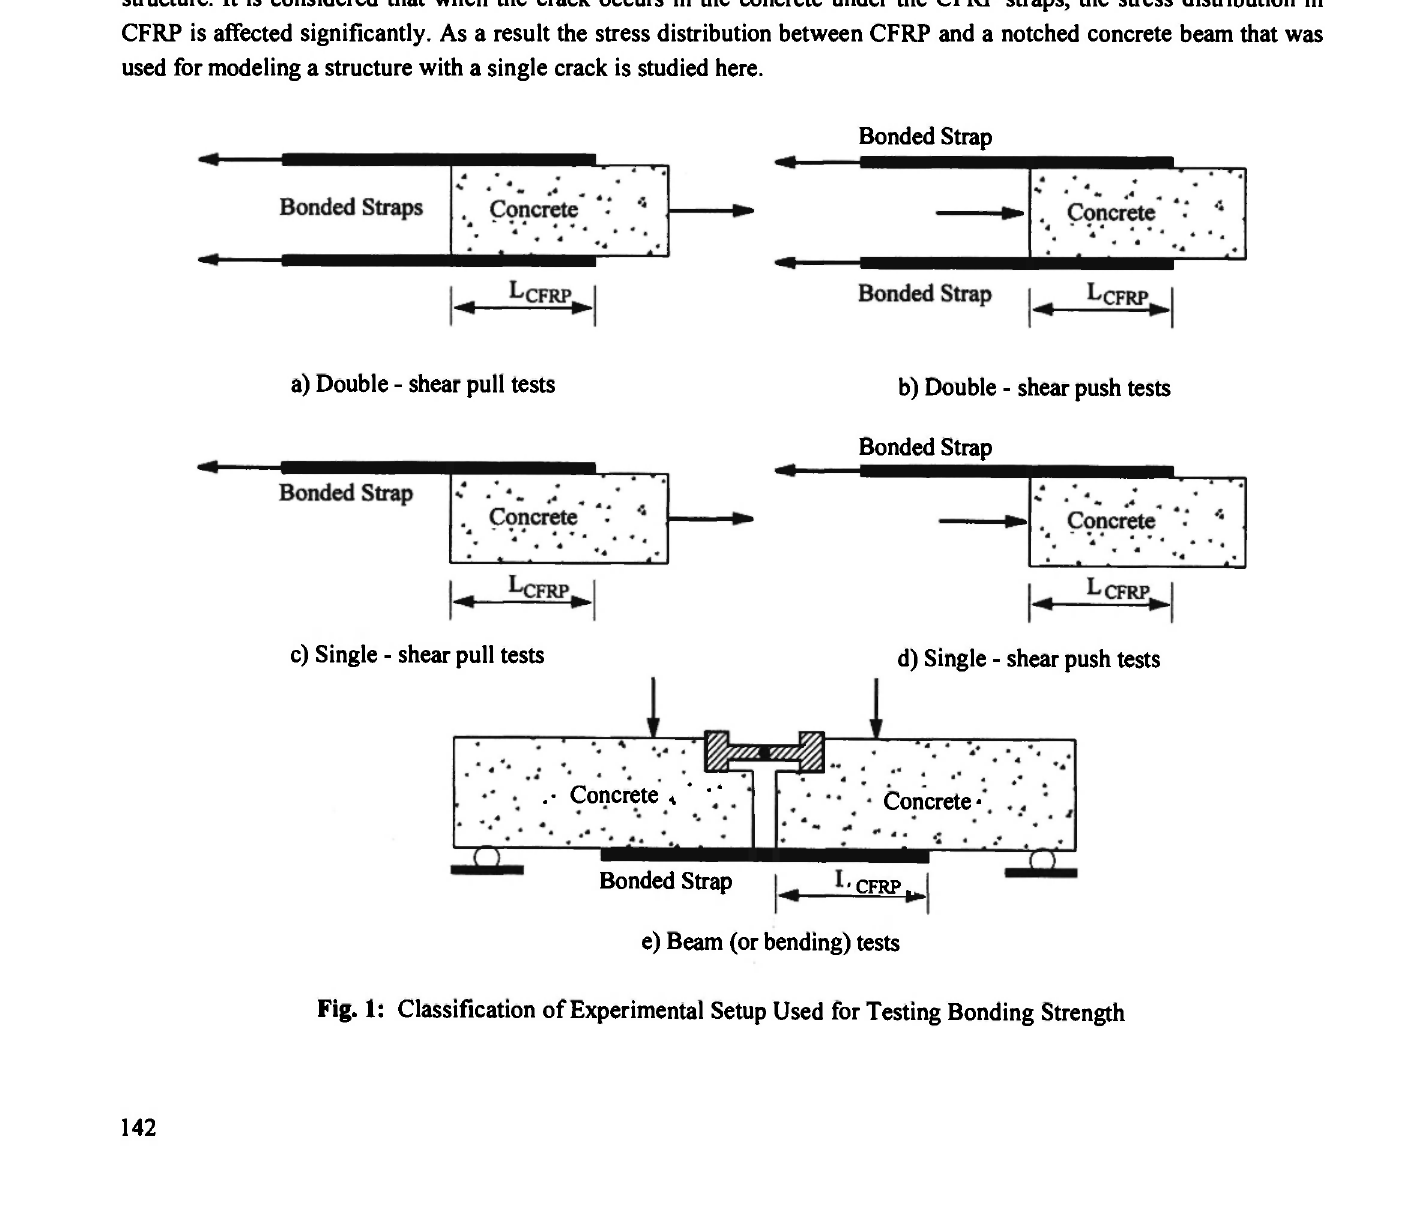
Fig. 1: Classification of Experimental Setup Used for Testing Bonding